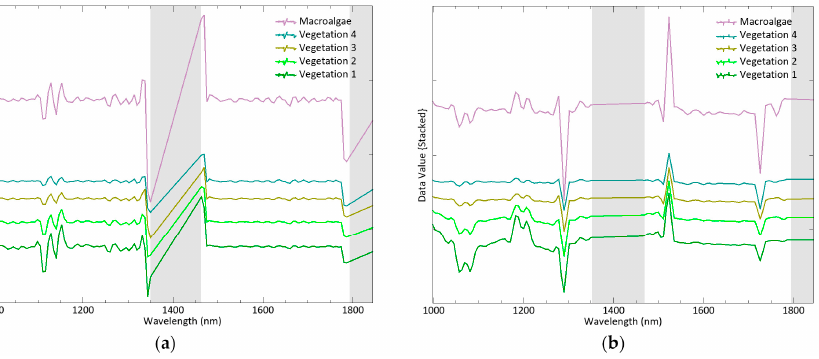
Figure A3. The focus is on the SWIR1 region of the electromagnetic spectrum. The main peaks can be identified in the 2nd derivative spectrum of the five studied spectral signatures ( a ). The boxcar average smoothing filter applied on the 2nd derivative spectrum highlights other important peaks for the studied signatures ( b ). Significant absorption peaks are present at 1039, 1098, 1128, 1152, 1188, 1206, 1331, 1499, 1523, 1594, 1636, 1672, 1690, and 1774 nm. In grey are the water vapour absorbance regions (1350–1460 nm and 1790–1960 nm) excluded from the hyperspectral processing.